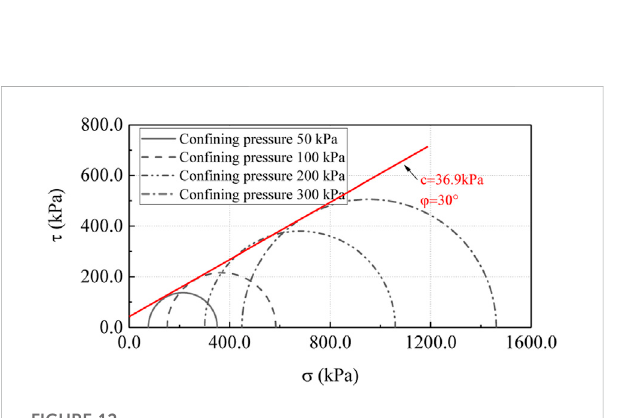
FIGURE 12 Shear strength of pure